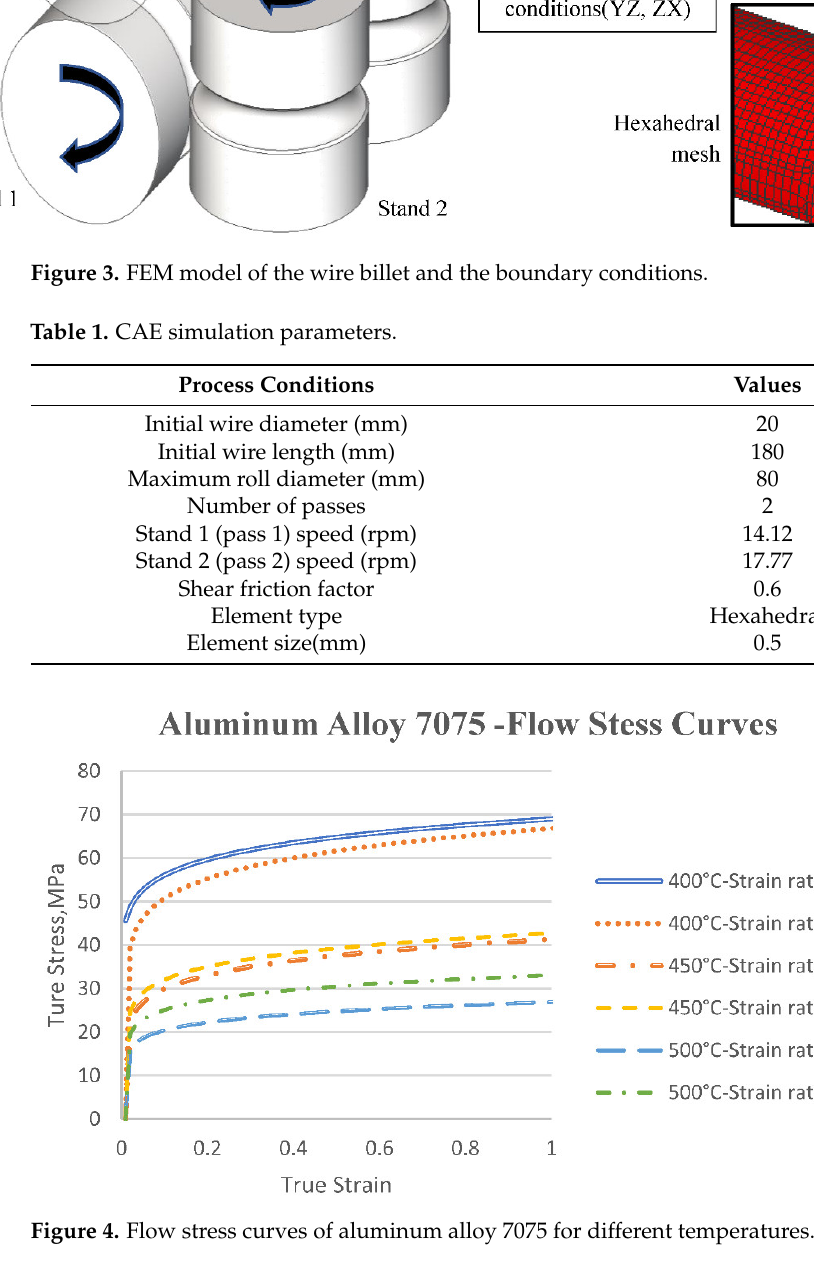
Figure 4. Flow stress curves of aluminum alloy 7075 for different